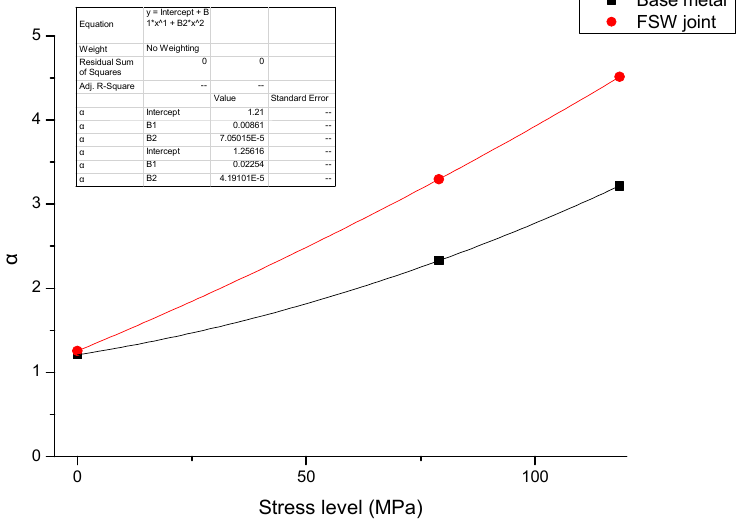
Figure 19. Variation of maximum corrosion depth ( µ m) with applied stress level (MPa) for the two chosen specimens of aluminum alloy 2219. Duration of exposure to environment is 48 h.